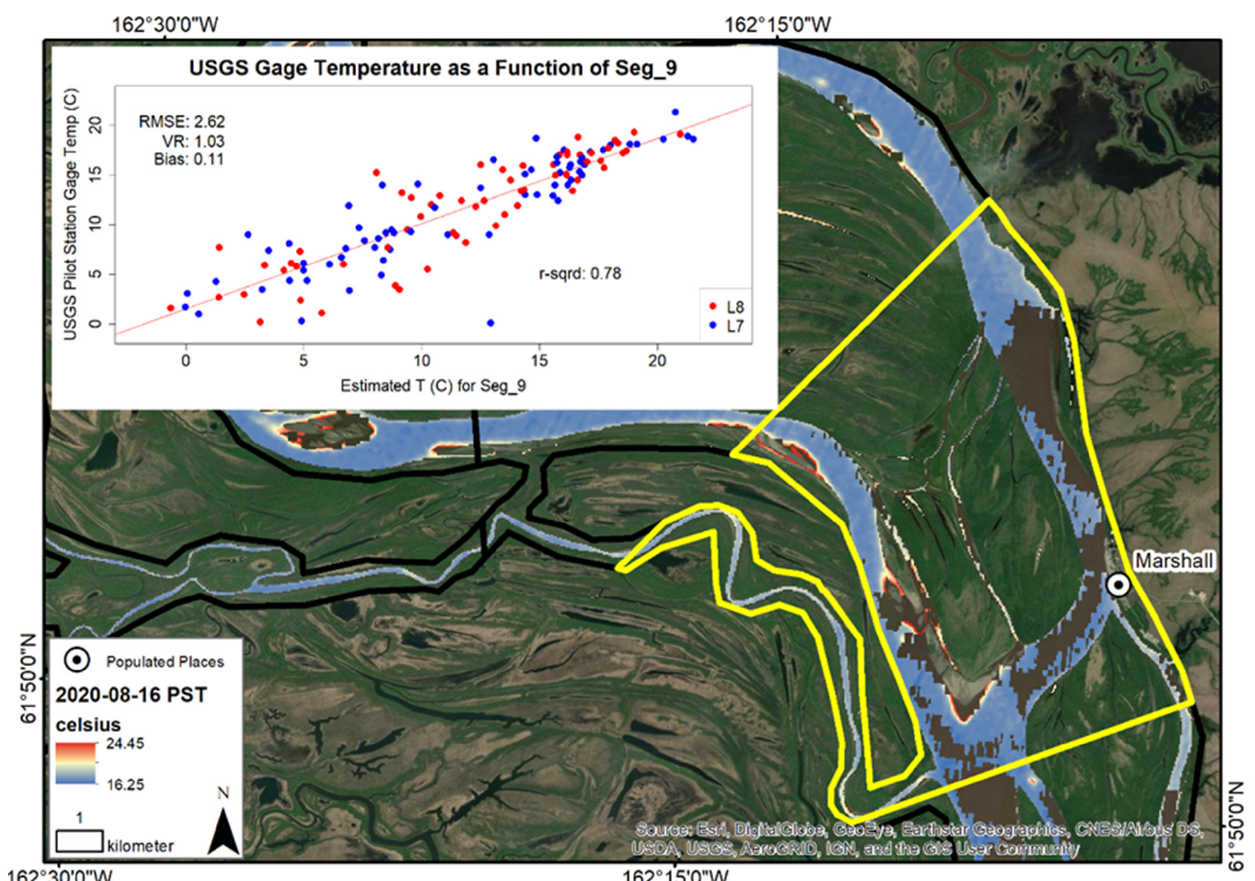
Figure A7. Segment 9 captures a large series of islands that split the Yukon River within this segment. The majority of the flow passes to the east as Poltes Slough while passing the community of Marshall at the terminal foothills of the Ilivit Mountains. Owl Creek also enters the Yukon River here. While the name suggests that Owl Creek flows into the Yukon, the heavy sediment content of Owl Creek and its numerous connections to the main stem of the Yukon as seen in high resolution imagery suggest the creek functioning more as a slough. For this reason, it is included in our analysis. Several large NoData gaps occur within the main stem and Poltes Slough. Like segment 8, correlation with measured water temperature is slightly lower within this segment but is still relatively good (RMSE = 2.62 °C, r 2 =0.78).